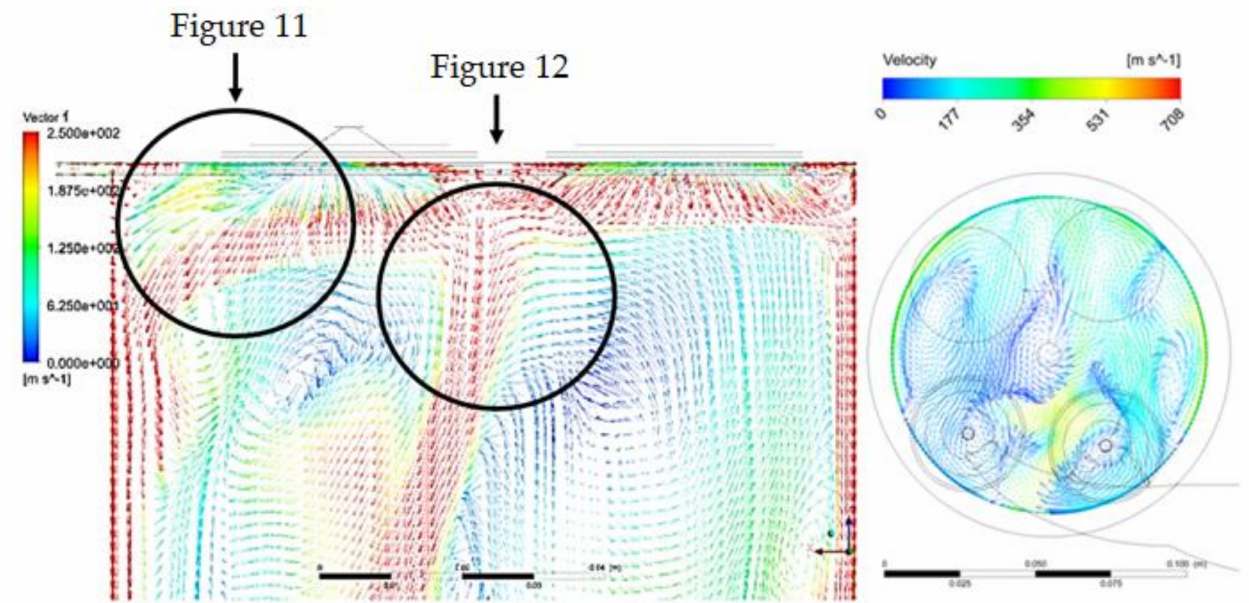
Figure 13. Annotated comparison of RANS CFD work by Firmansyah et al. [34] with the two the areas of focus in the Schlieren optical setups, at 2.5 MPa and low valve lift, presented in Figures 11 and 12. Reproduced from [34], with the permission of AIP